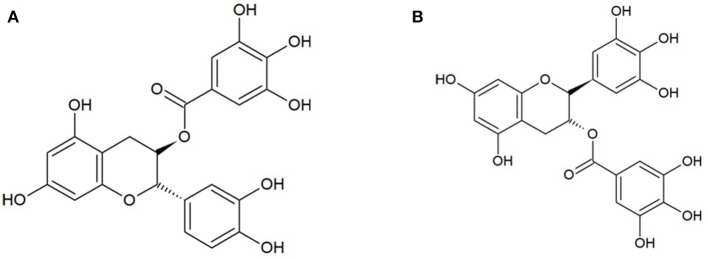
Catechins. (A) (-)-catechin gallate (C22H18O10); (B) (-)-gallocatechin (C22H18O11).